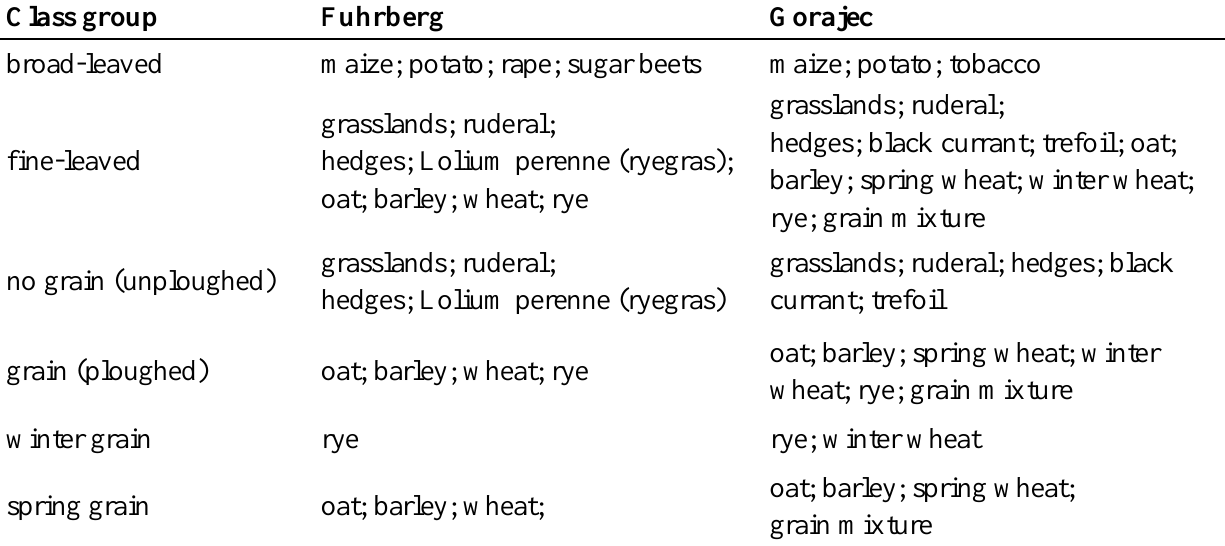
Table 3. Distribution of single classes within class